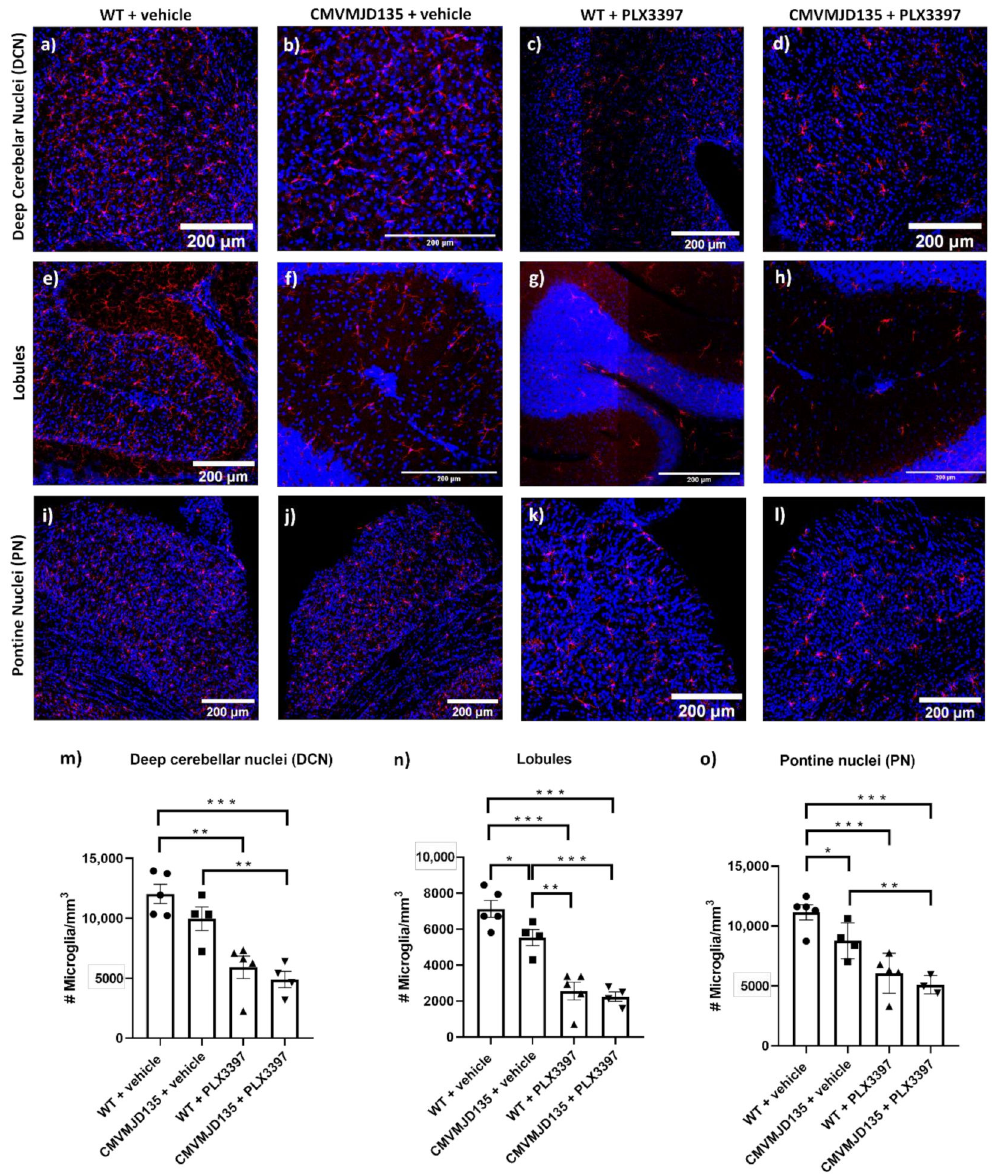
Figure 1. Microglial population halved by PLX3397 in CMVMJD135 mice. ( a – l ) Representative images of microglial cells, using Iba-1 as a microglia marker (in red), from the deep cerebellar nuclei (DCN) ( a – d ) and from the lobules ( e – h ), of the cerebellum, and from the pontine nuclei (PN) ( i – l ), in the brainstem of wild-type (WT) and CMVMJD135 mice treated with PLX3397 ( c , d , g , h , k , l ) or vehicle ( a , b , e , f , i , j ). ( m – o ) Quantitative analysis of the number of microglial cells per mm 3 in the ( m ) DCN, ( n ) lobules, and ( o ) PN from PLX3397 or vehicle-treated WT and CMVMJD135 mice ( n = 3–5 animals per group). The symbols • , (cid:4) , (cid:78) , and (cid:72) stand for the WT + vehicle, CMVMJD135 + vehicle, WT + PLX3397, and CMVMJD135 + PLX3397 groups, respectively. Data are presented as mean +